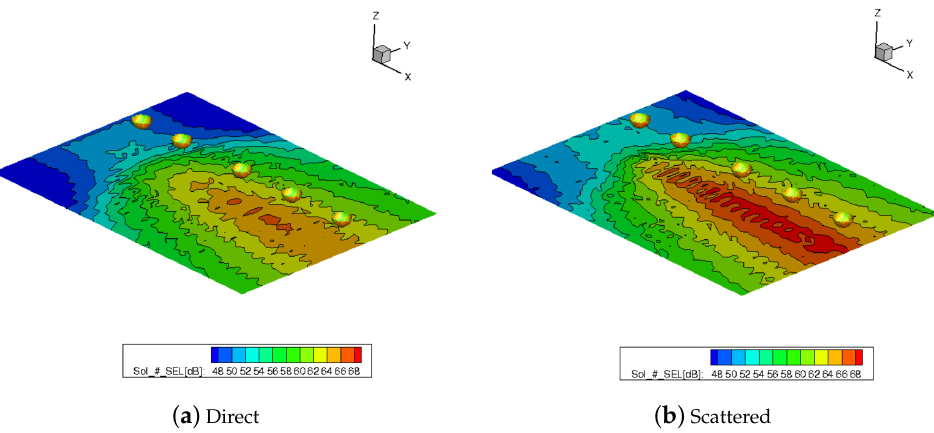
Figure 22. Comparison of Sound Exposure Level carpets. BLI case without acoustic installation effects ( a ) and with installation effects ( b